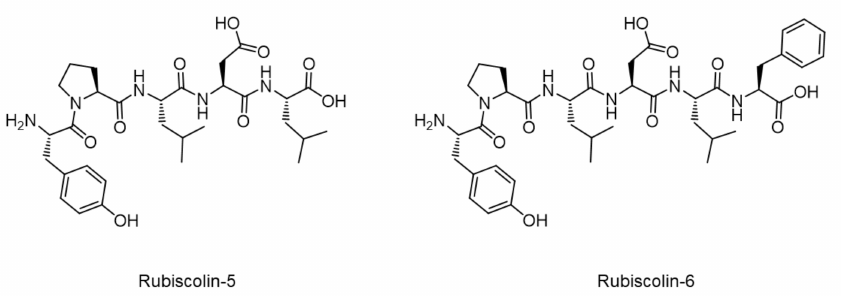
Figure 1. Molecular structures of